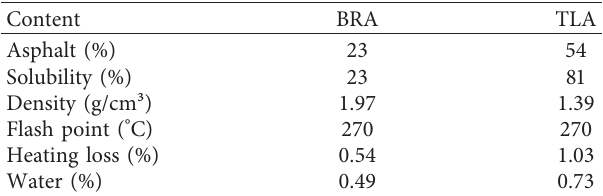
Table 2: Basic properties of natural asphalt.